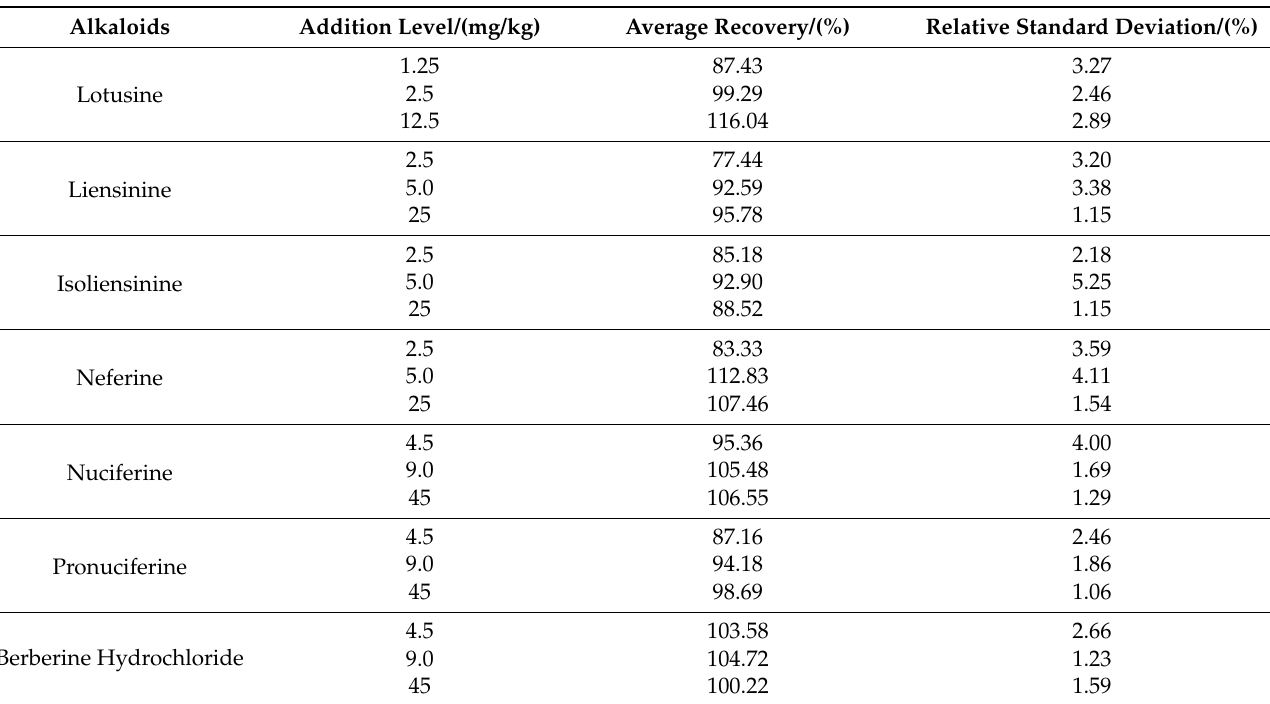
Table 5. Recovery and precision of 7 kinds of alkaloids (n =